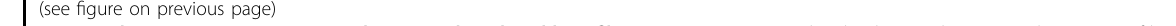
Fig. 3 Reducing ATF3 expression ameliorates CCl4-induced liver fi brosis. Mice were treated with oil in combination with injection of lenti-NC (negative control, n = 10), or CCl 4 in combination with injection of lenti-NC (NC + CCl 4 , n = 10), or oil in combination with injection of lenti-ATF3- shRNA1/2 (ATF3-shRNA1/2, n = 10), or CCl 4 in combination with injection of lenti-ATF3-shRNA1/2, (ATF3-shRNA1/2 + CCl 4 , n = 10). a Liver fi brosis was evaluated by macroscopic examination, H&E staining, Sirius red staining, and IHC for α -SMA. b The mRNA level of hepatic pro- fi brogenic genes ( α -SMA, Col1 α 1, Col3 α 1,Col4 α 5, Mmp2 , Mmp9 , and Timp1) was determined by qRT-PCR. c The protein level of ATF3, α -SMA, COL1, and MMP2 were determined by western blot. GAPDH was used as an internal control. d Quanti fi cation of hepatic hydroxyproline content. The data were expressed as hydroxyproline ( μ g)/liver wet weight (g). The data were expressed as the mean ± SEM for at least triplicate experiments, */# p < 0.05; * p < 0.05 for vs NC; # p < 0.05 for vs NC + CCl 4